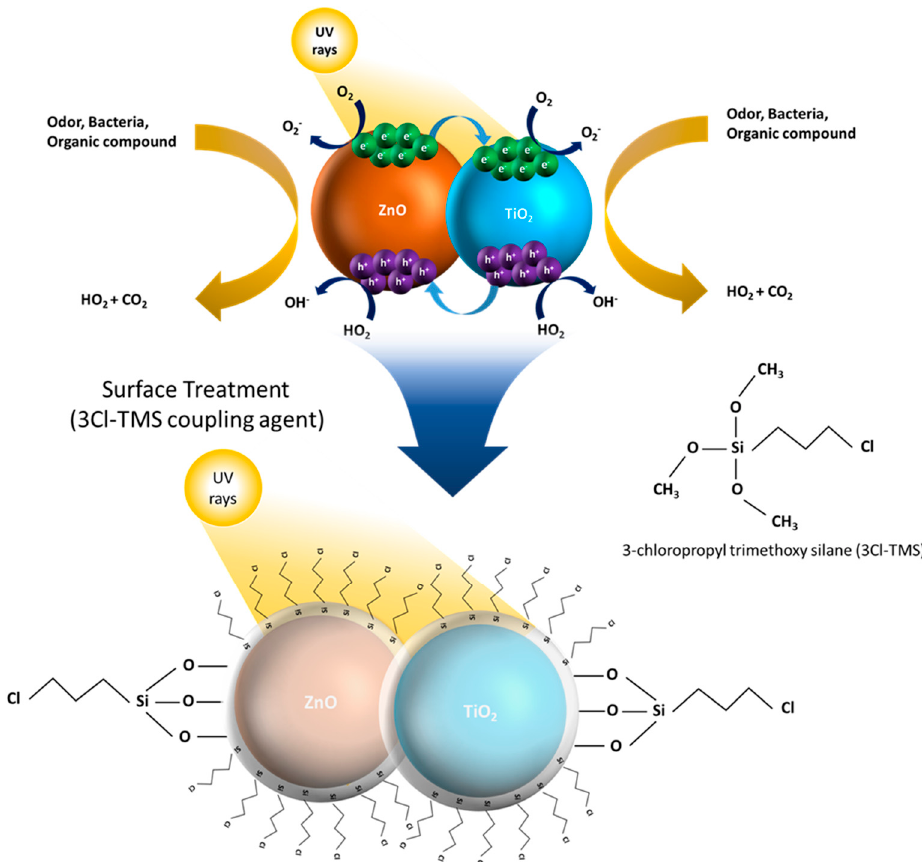
Figure 6. Mechanism for the treatment with 3Cl - TMS coupling agent of ZnO ‒ TiO 2 .